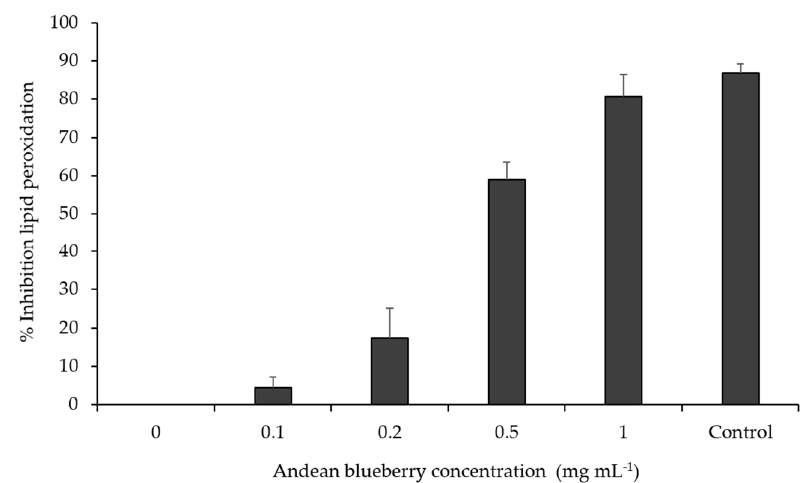
Figure 2. Inhibition of the lipid peroxidation in vivo using the zebrafish model. The zebrafish embryos were treated with concentrations of Andean blueberry in the range 0.1–1 mg mL − 1 . Butylated hydroxytoluene (BHT) was used as positive control (0.1 mg / mL). Results are mean values ( n = 3) ± standard deviation.